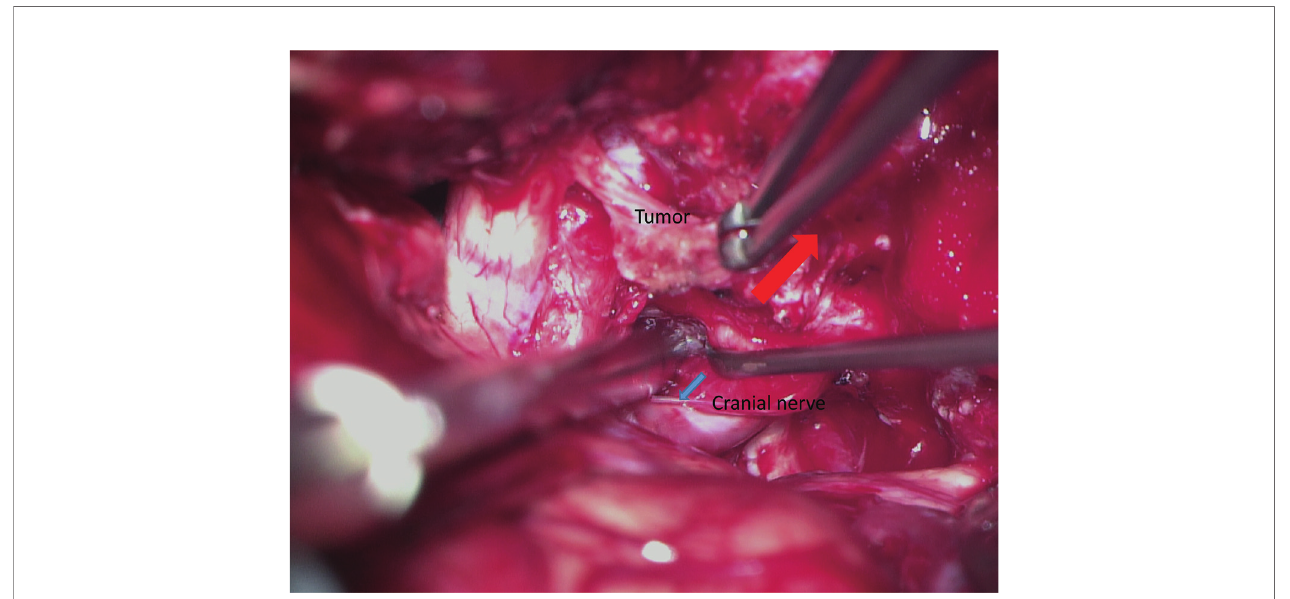
FIGURE 8 | The “ in situ ” technique for the preservation of neurological function. The supporter stably pulls the tumor by the cup forceps to create tension between the tumor and target nerve (red arrow). Using a dissector, the chief surgeon gently divides the tumor away from the nerve along with the arachnoid interface (blue